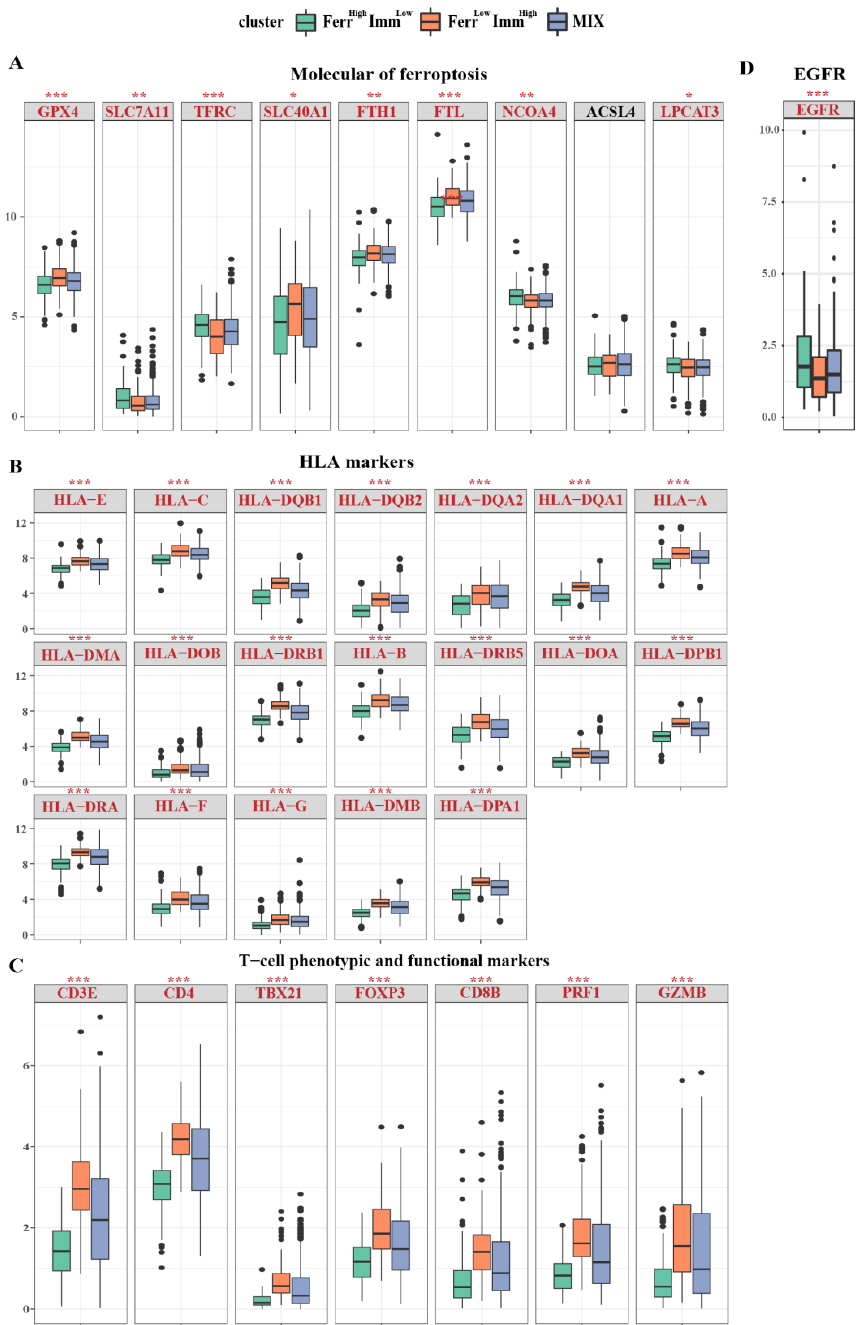
Figure 5. Distribution of individual expression of ferroptosis and immune − related genes among subtypes. Box and whisker plots show the expression of selected ferroptosis and immune-related genes between three groups. ( A ) The expression of ferroptosis − related genes between three groups; ( B ) The expression of HLA marker genes between three groups; ( C ) The expression of T cell phenotype and functional marker genes between three groups; ( D ) The EGFR expression between three groups; Data were analyzed using Kruskal – Wallis test; P values are reported as: * p < 0.05; ** p < 0.01; *** p < 0.001.